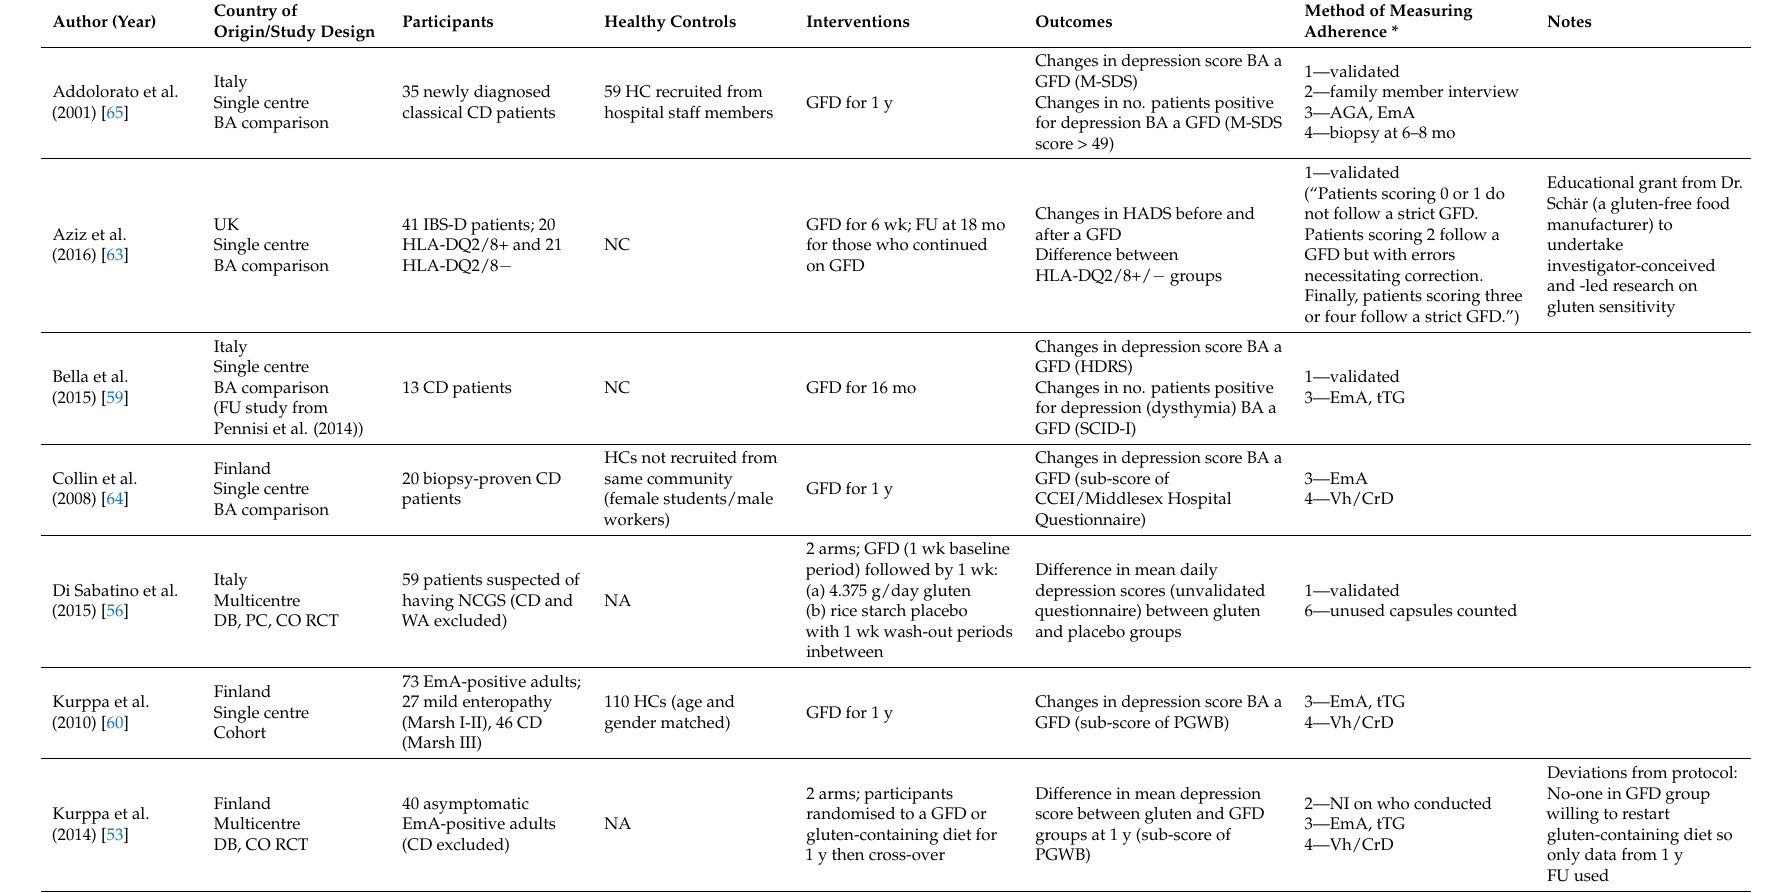
Table 1. Characteristics of included